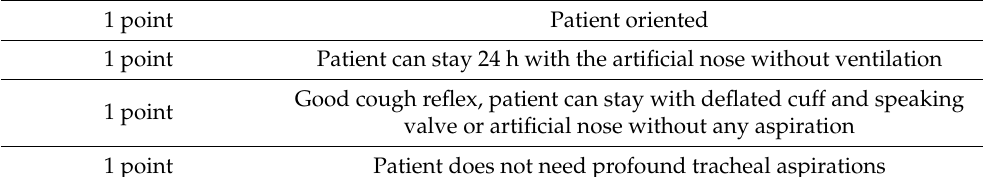
Table 1. Tracheo Score Index (TSI). 1 point Patient oriented 1